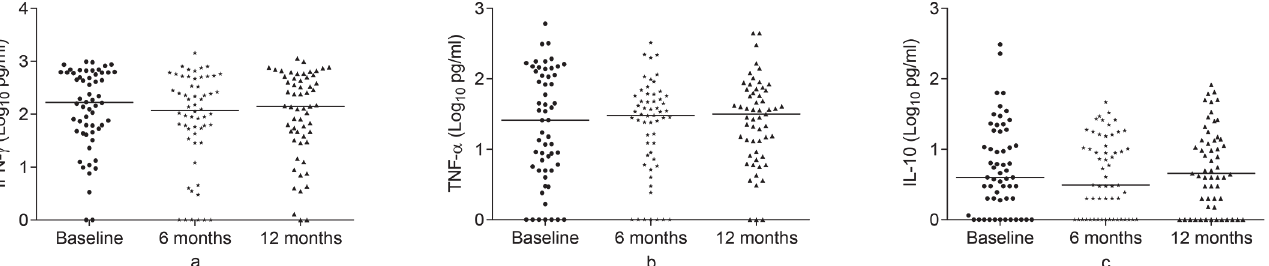
Fig 10. Changes in cytokine responses to E6C10 over 12 months in patients. IFN- γ (a), TNF- α (b) and IL-10 (c) responses to E6C10 in patients at baseline, 6 and 12 months following whole blood stimulation with E6C10 for 48 hours. Filled circles represent baseline levels, filled diamonds represent 6 month levels and filled triangles represent 12 month levels. Results are individual responses and cytokine levels are expressed as log 10 pg/ml. Horizontal bars are medians. Freidman test with Dunn ’ s multiple comparisons was used to compare cytokine levels overtime.